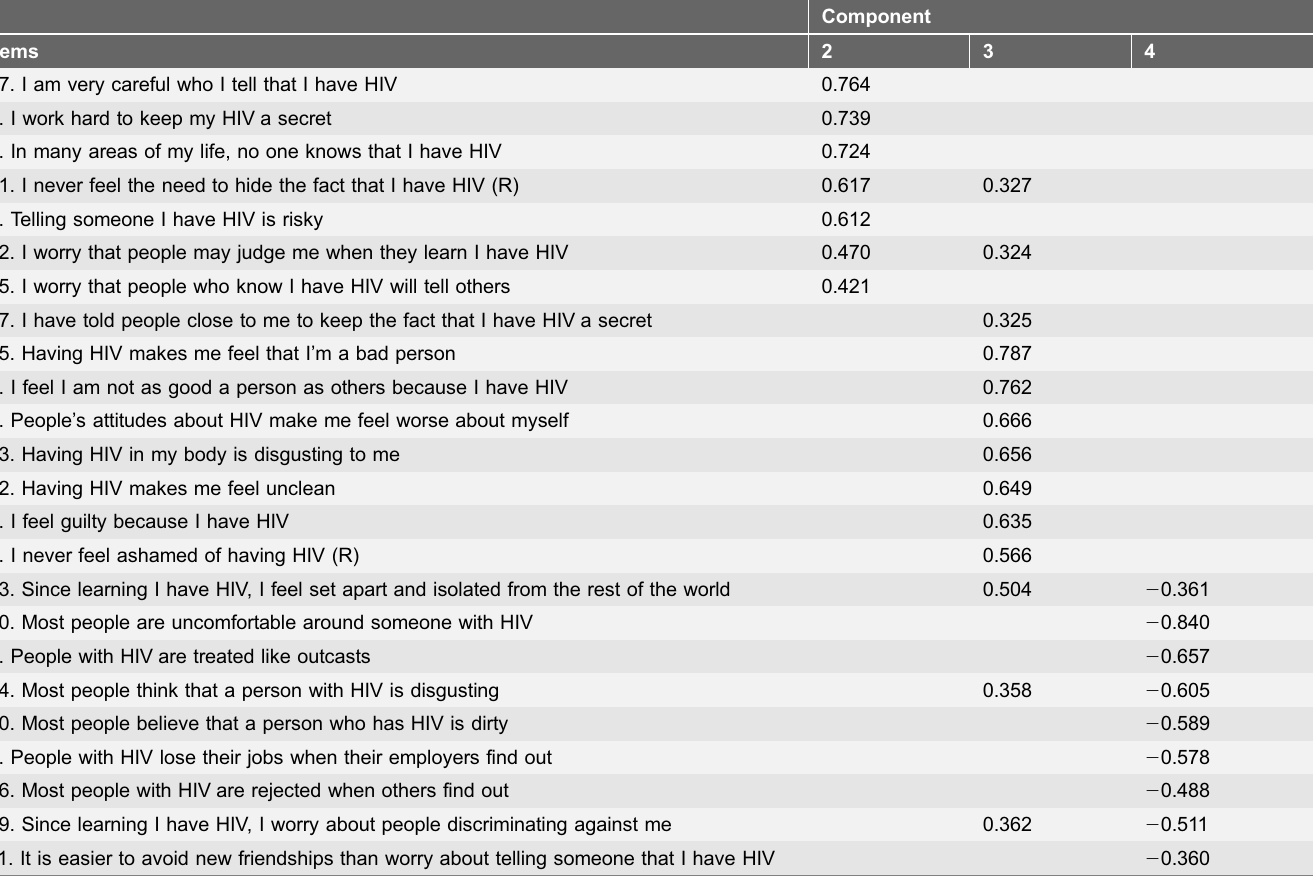
Table 6. Factor loadings for items in the HIV stigma scale, items belonging to the dimension personalised stigma excluded. a